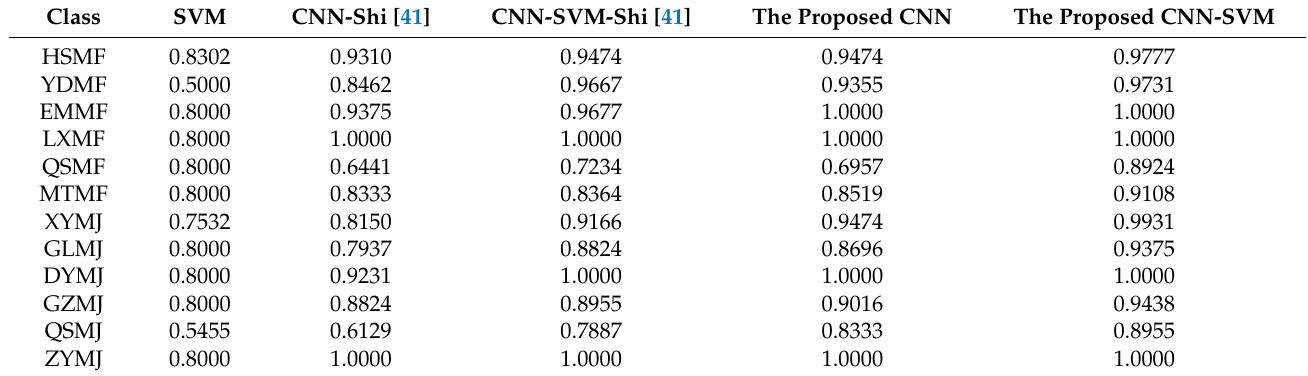
Table 5. Results of F1 scores for classifications by five